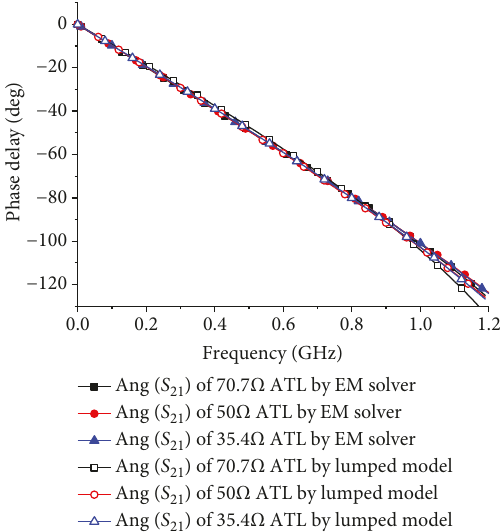
Figure 8: Simulated phase delay of the proposed